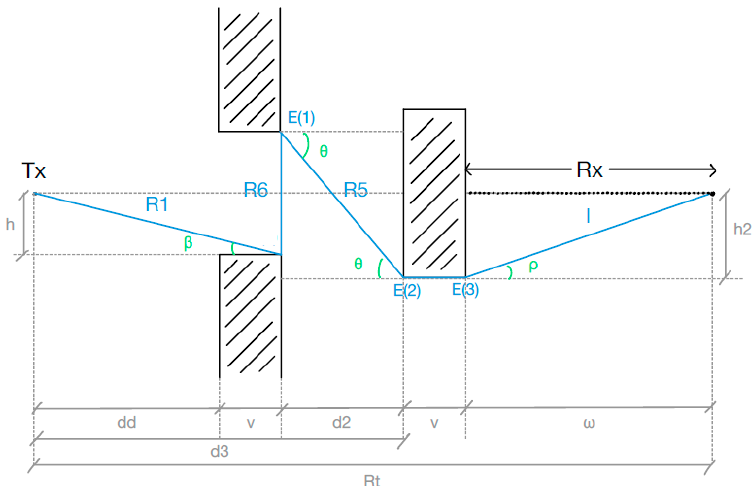
Figure 24. Third quadruple diffraction (Edif_q3) of the second considered NLOS scenario.